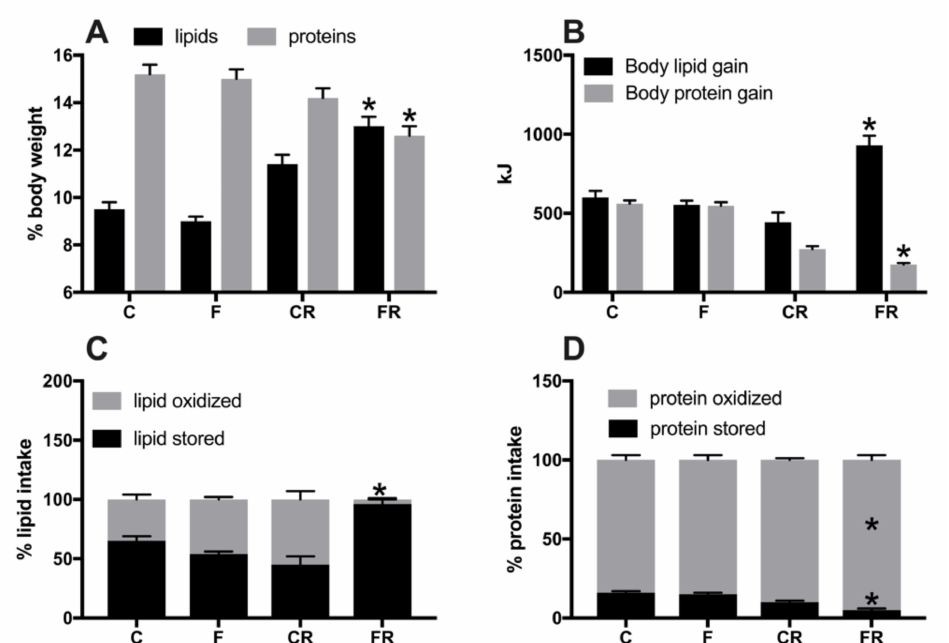
Figure 3. Body lipid and protein content ( A ), body lipid and protein gain ( B ), lipid ( C ) and protein ( D ) partitioning in control (C), fructose (F), control rescue (CR), and fructose rescue (FR) rats. Values are the means ± SEM of eight different rats. * p < 0.05 compared to respective control (one-way ANOVA followed by Tukey